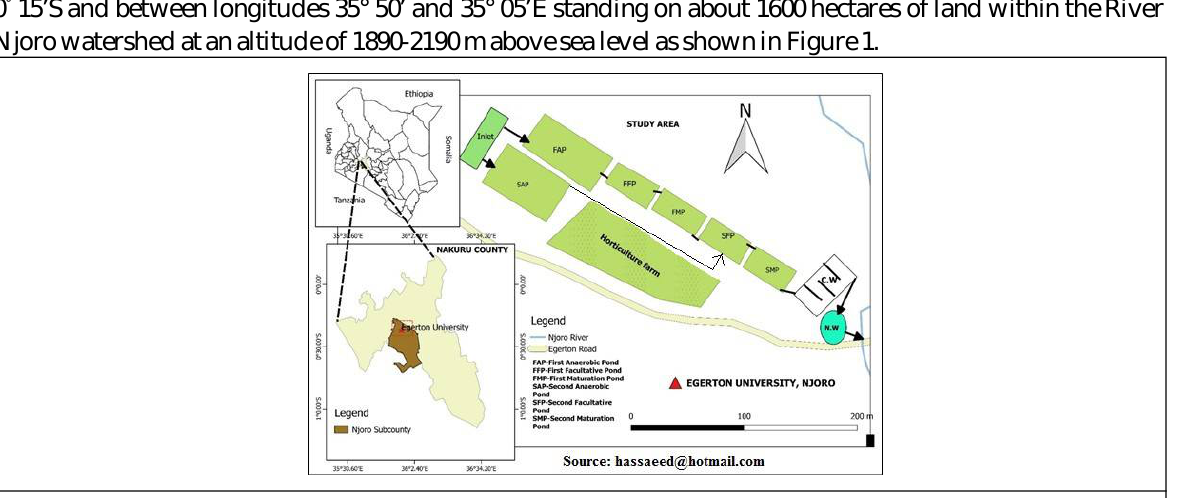
Figure 1: Map of Egerton University, Njoro showing the layout of the wastewater stabilization